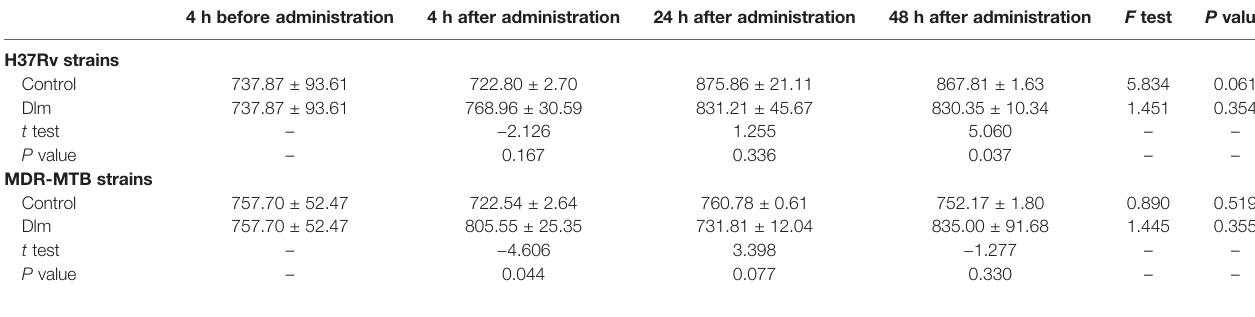
TABLE 2 | The level of IL-12/23 p40 in the culture supernatant of macrophages infected by MDR-MTB after Dlm was administered (pg/ml, (cid:1) x ± s